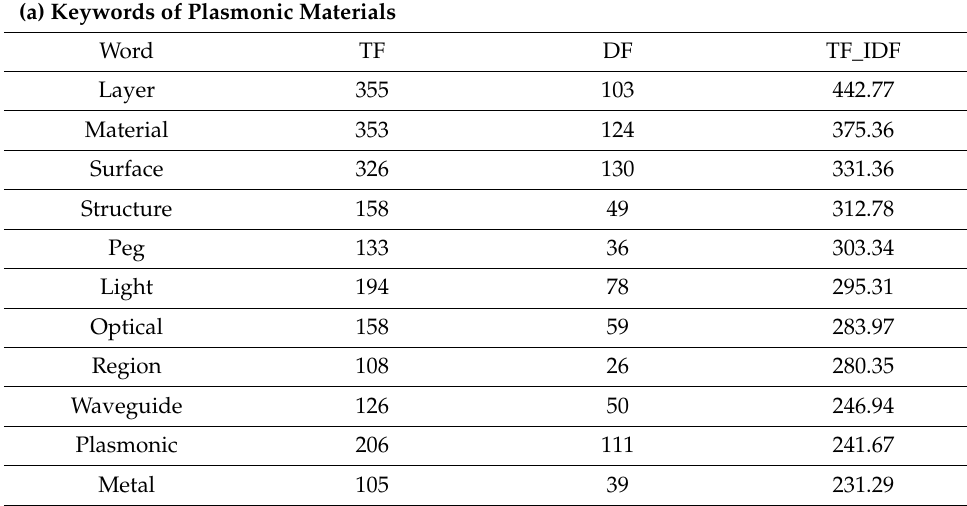
Table 4. Keywords extracted based on TF-IDF.